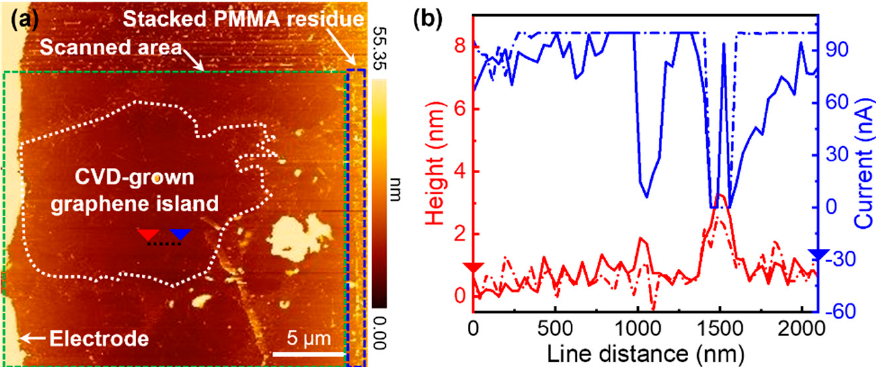
Figure 3. ( a ) AFM topography image of a CVD-grown monolayer graphene flake on SiO 2 after the removal of the polymer residue. ( b ) The line profile of the current and morphology of the flake along the dashed line marked in ( a ).